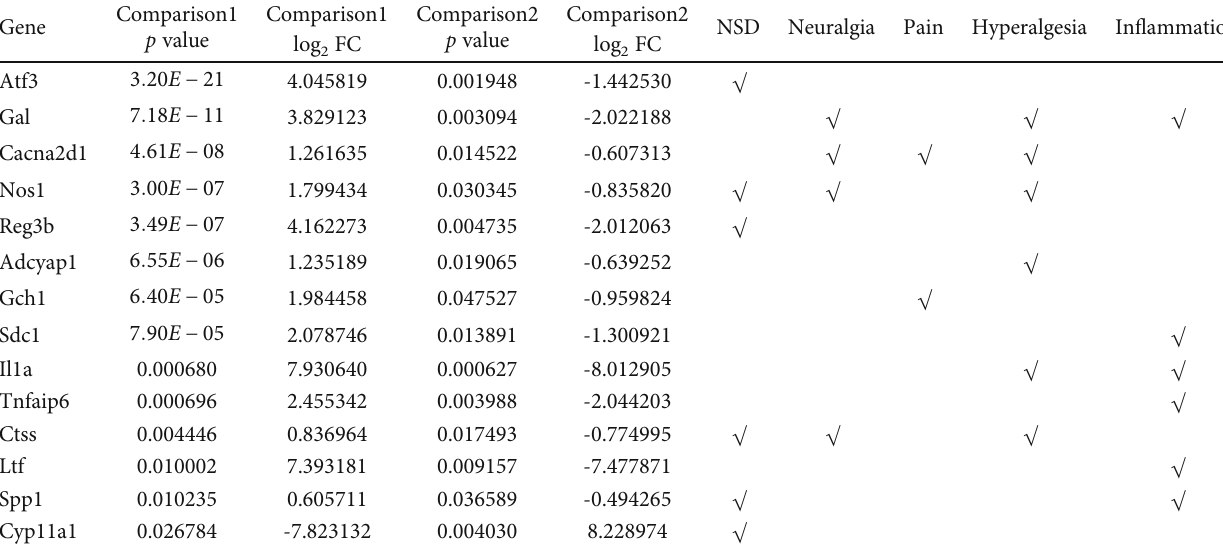
Table 2: Comparison of di ff erentially expressed mRNAs with NP-related phenotypes in RGD database. Comparison1 Gene p value